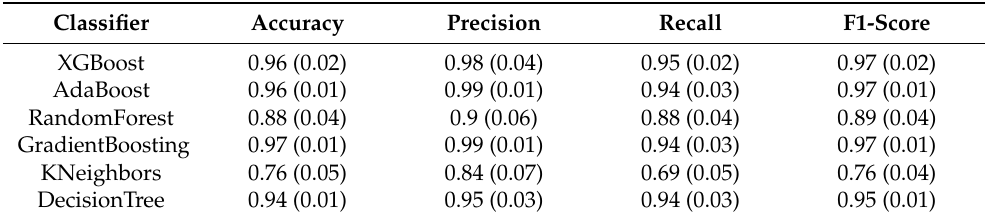
Table 10. Models’ performance for Gaussian Spreading with only small packets after applying class weight (standard deviation in